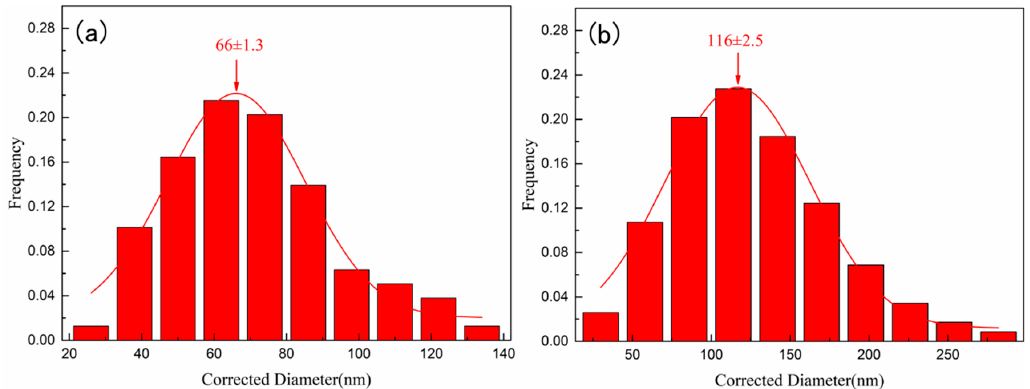
Figure 2. Corrected size distribution was measured in HAADF-STEM after aging at 170 °C for 20 h. ( a ) θ ' phase, ( b ) T 1 phase. Table 2. Yield strength and quantitative measurements of T 1 and θ ' precipitates in specimens aged at 170 °C. Aging Time (h)